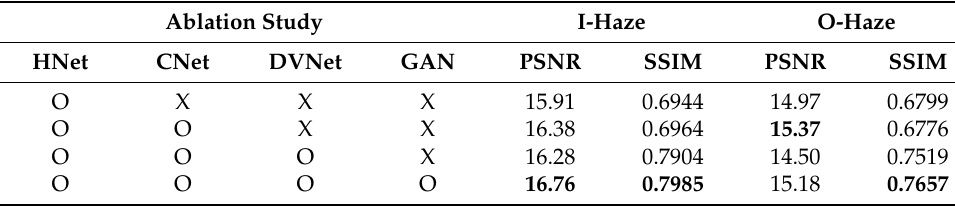
Table 6. Ablation Study, where bold numbers are best